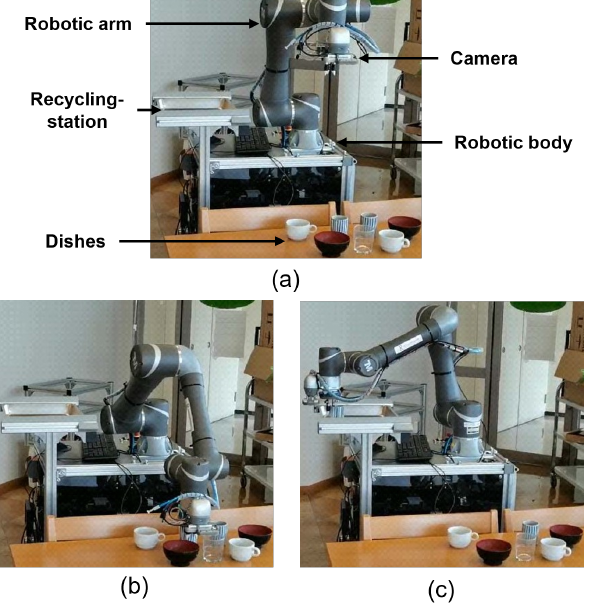
Figure 2. Working process of the proposed empty-dish recycling robot. ( a ) preparation stage, ( b ) grasping process, ( c ) recycling process.